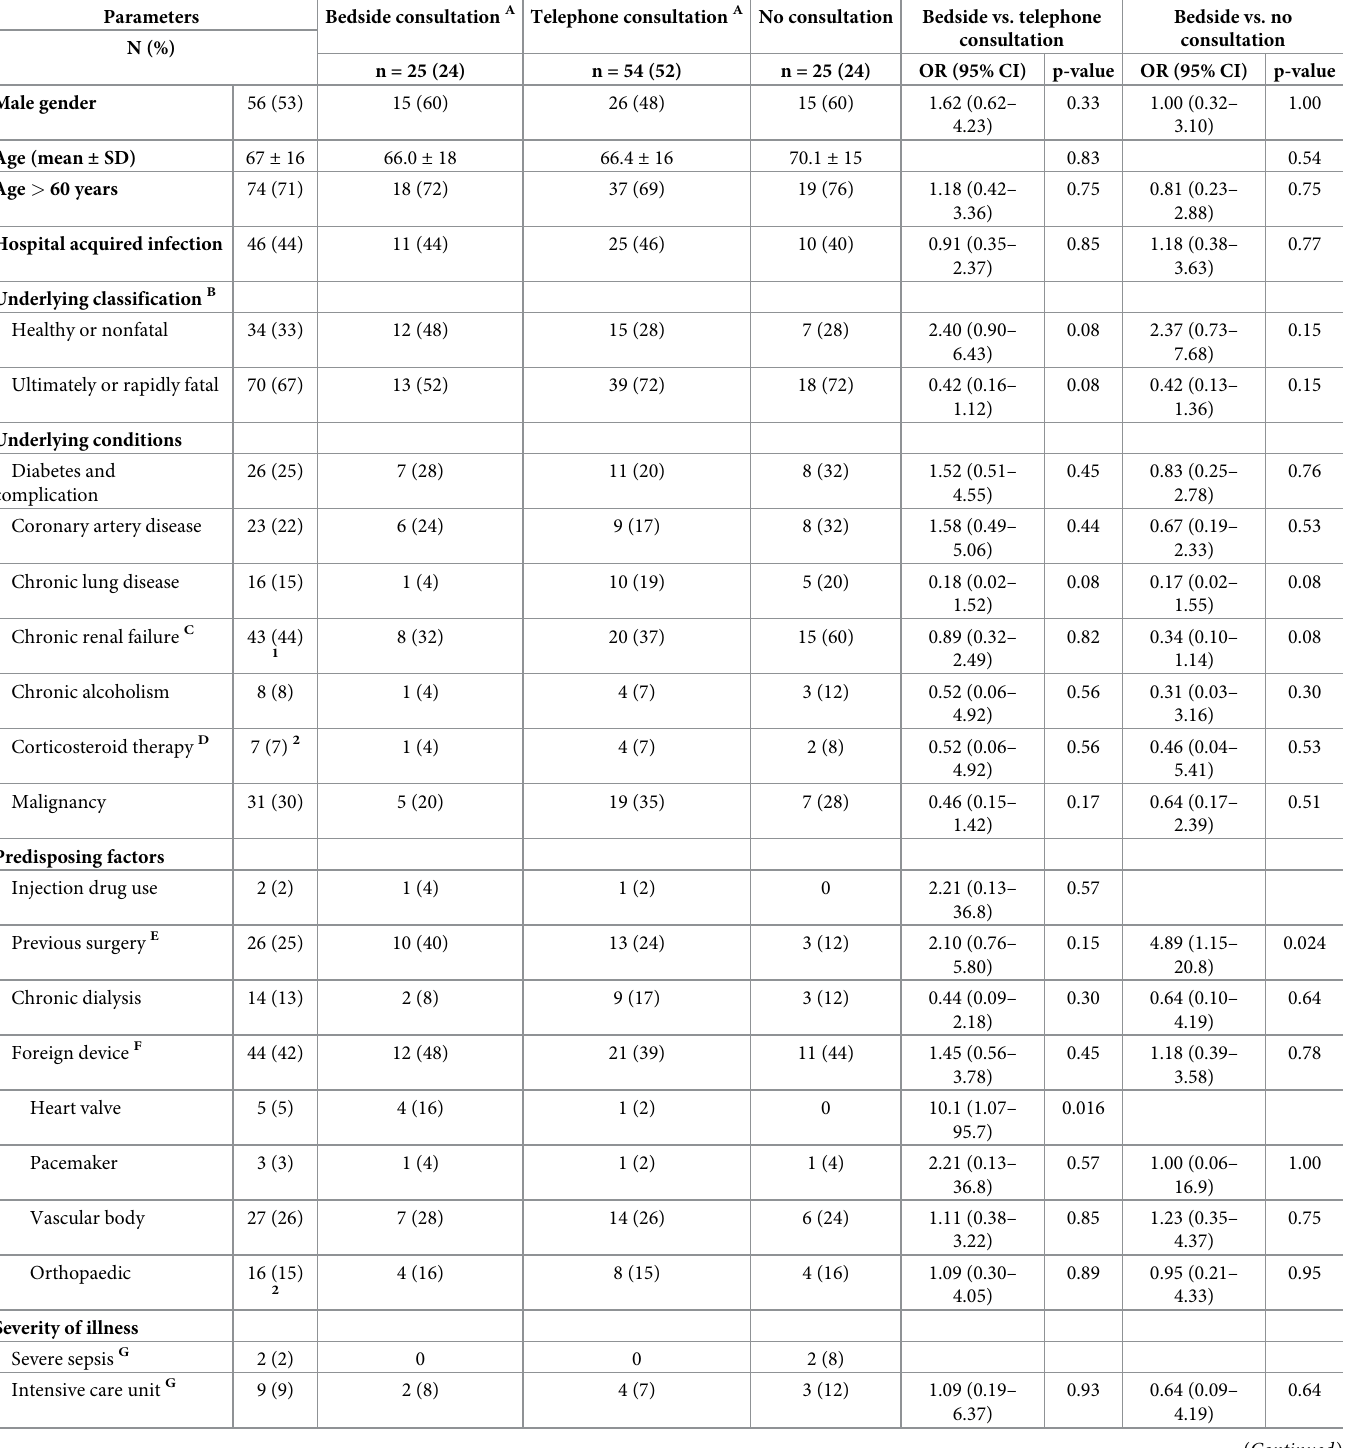
Table 2. Characteristics, predisposing factors and illness severity of 104 patients with Staphylococcus lugdunensis bacteraemia stratified according to infectious dis- ease specialist consultation.